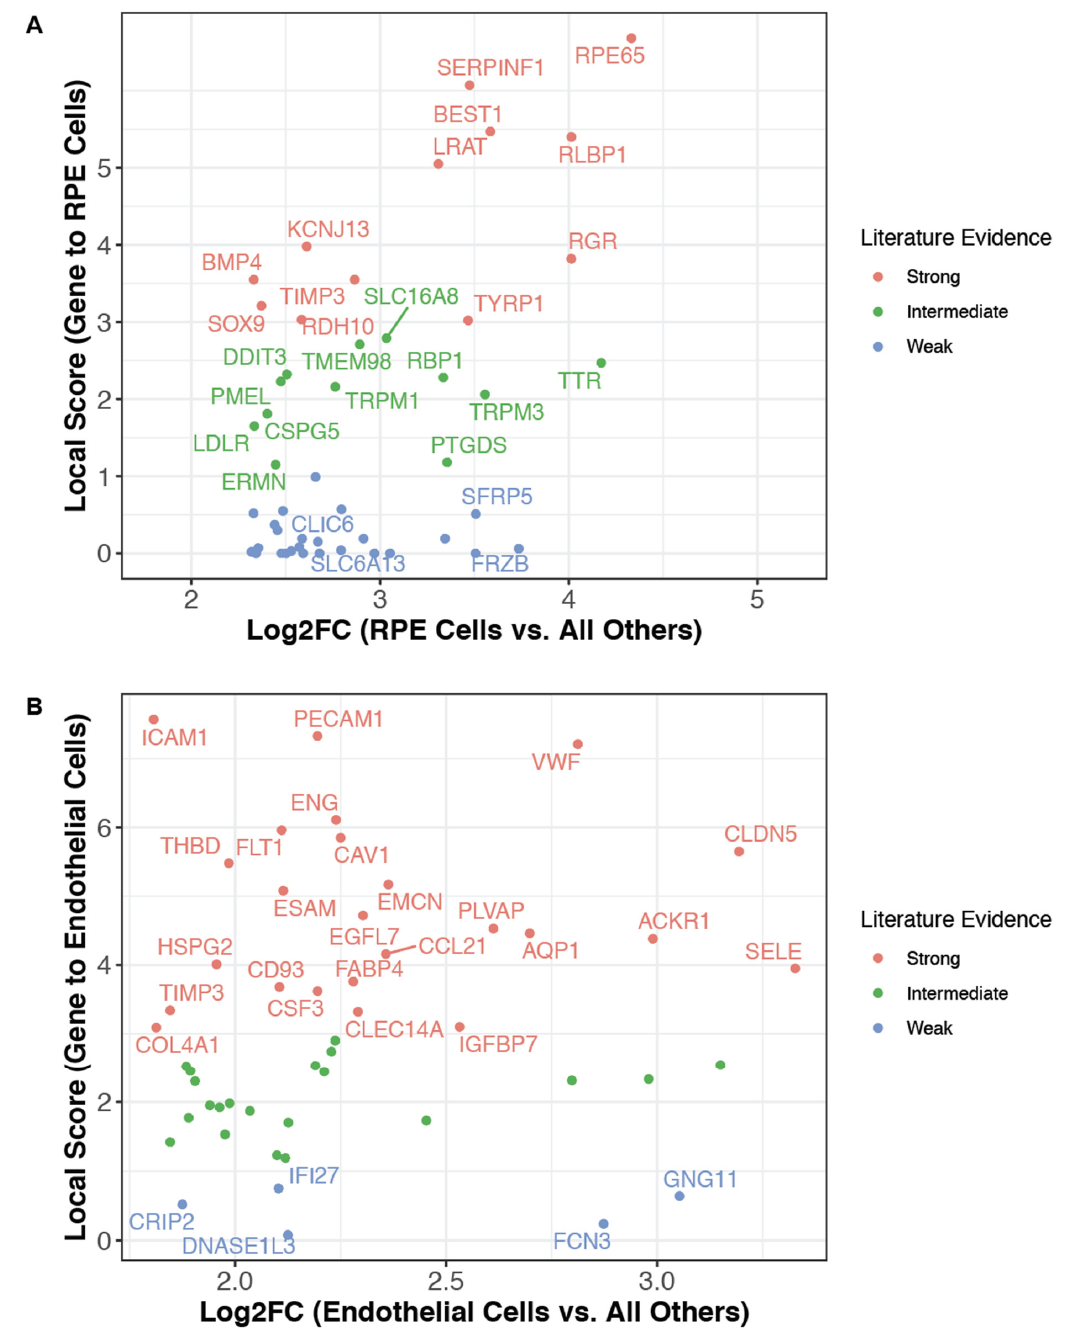
Figure 7. Literature-derived GCAs contextualize differentially expressed genes, highlighting poorly characterized markers of established cell types. ( A ) Transcriptional markers of retinal pigment epithelial (RPE) cells were identified by comparing the mean expression of all genes in RPE cells from two scRNA-seq studies [30,68] to their expression in all other cells from our reference datasets (see Supplemental File S8). The top 50 markers (ranked by fold change) were classified for their level of literature association to retinal pigment epithelial cells as follows: strong: Local Score ≥ 3; intermediate: Local Score ≥ 1 and <3; weak: Local Score < 1. All genes with strong or intermediate evidence are highlighted by name, as are a subset of the genes with weak evidence that may warrant further evaluation. ( B ) The same process was applied as in ( A ), but for endothelial cells from 31 studies [26–28,30,33,35–40,42,43,46–53,55,56,62,64,67,72–76,78,79] rather than for RPE cells. Here, all genes with strong or weak evidence are highlighted by name.